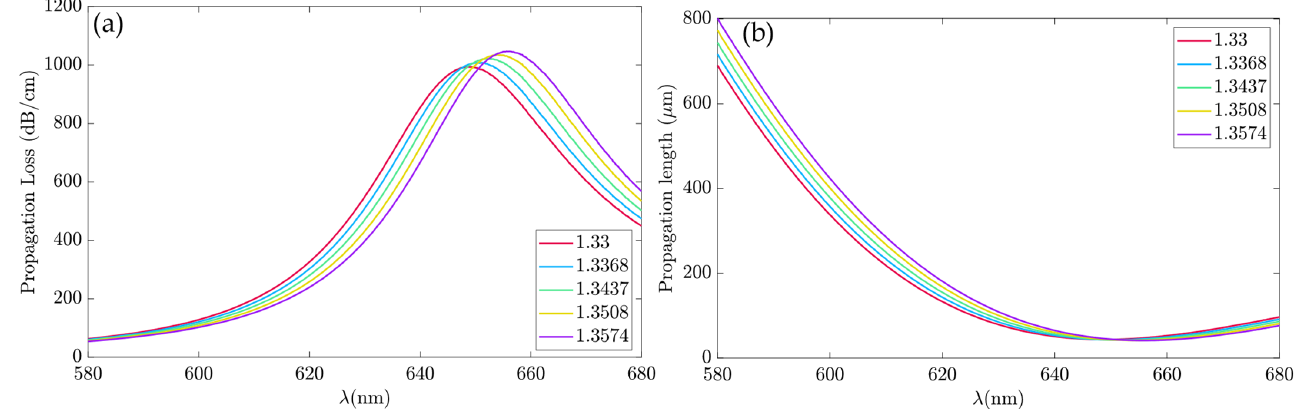
Figure 11. The propagation loss and propagation length spectrum for different glycerol concentrations. ( a ) Propagation loss. ( b ) Propagation length.